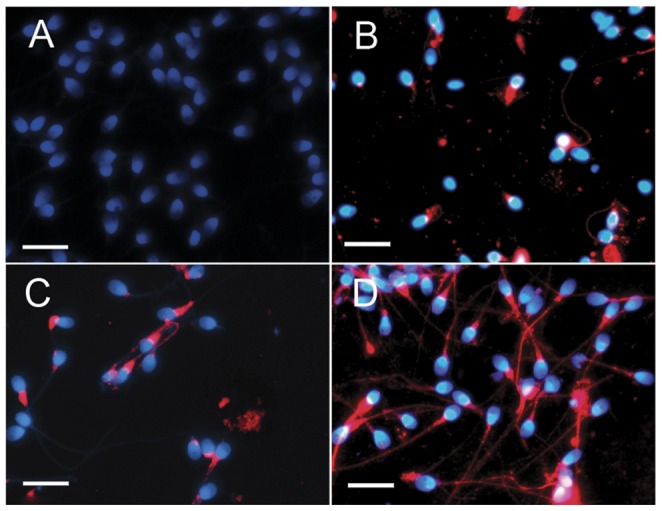
Hsp90 expression in human sperm under various conditions.Sperm were stained with Hsp90 antibody (red) or rabbit IgG (control). Hoechst 33258 staining (blue) marks cell nuclei. A) Negative control, rabbit IgG used as the primary antibody. B) Sperm not subjected to Percoll isolation. C) Sperm isolated using Percoll isolation (0 h) D) Sperm isolated using Percoll under capacitation conditions (3 h). Bar  = 10 µm. Experiments were performed using specimens collected from five different men.